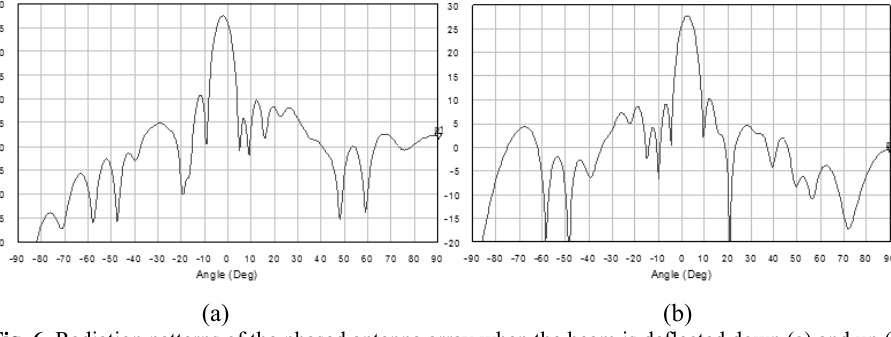
Fig. 6. Radiation patterns of the phased antenna array when the beam is deflected down (a) and up (b) in the elevation